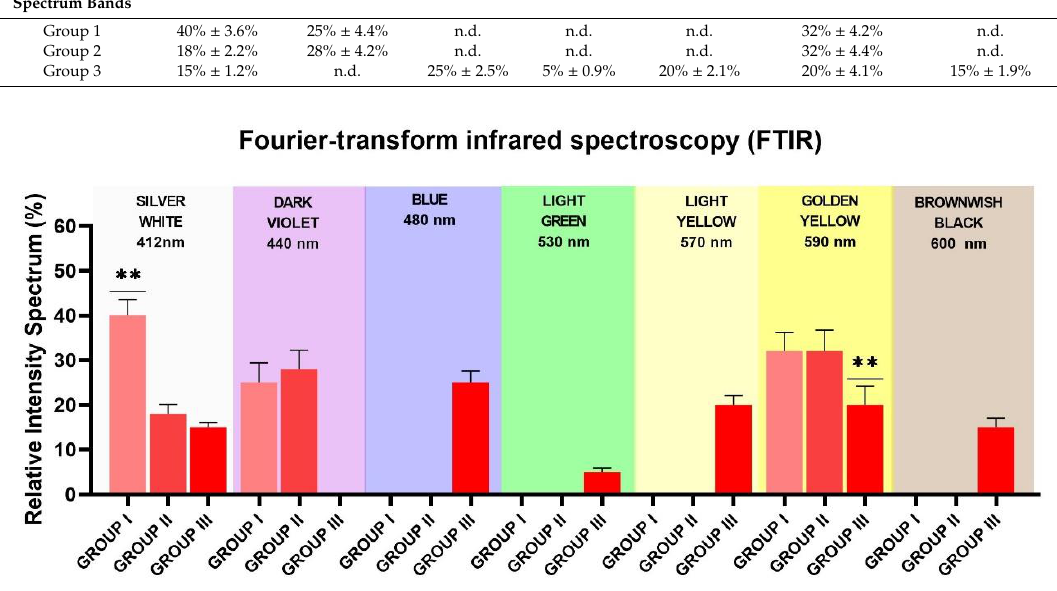
Figure 5. Fourier-transform infrared spectroscopy (FTIR) relative intensity spectrum bands of control and two di ff erently treated titanium disks. Group 1 (no treatment), Group 2 (1 W and 100 mJ / pulse) and Group 3 (4 W and 400 mJ / pulse) (** = p <